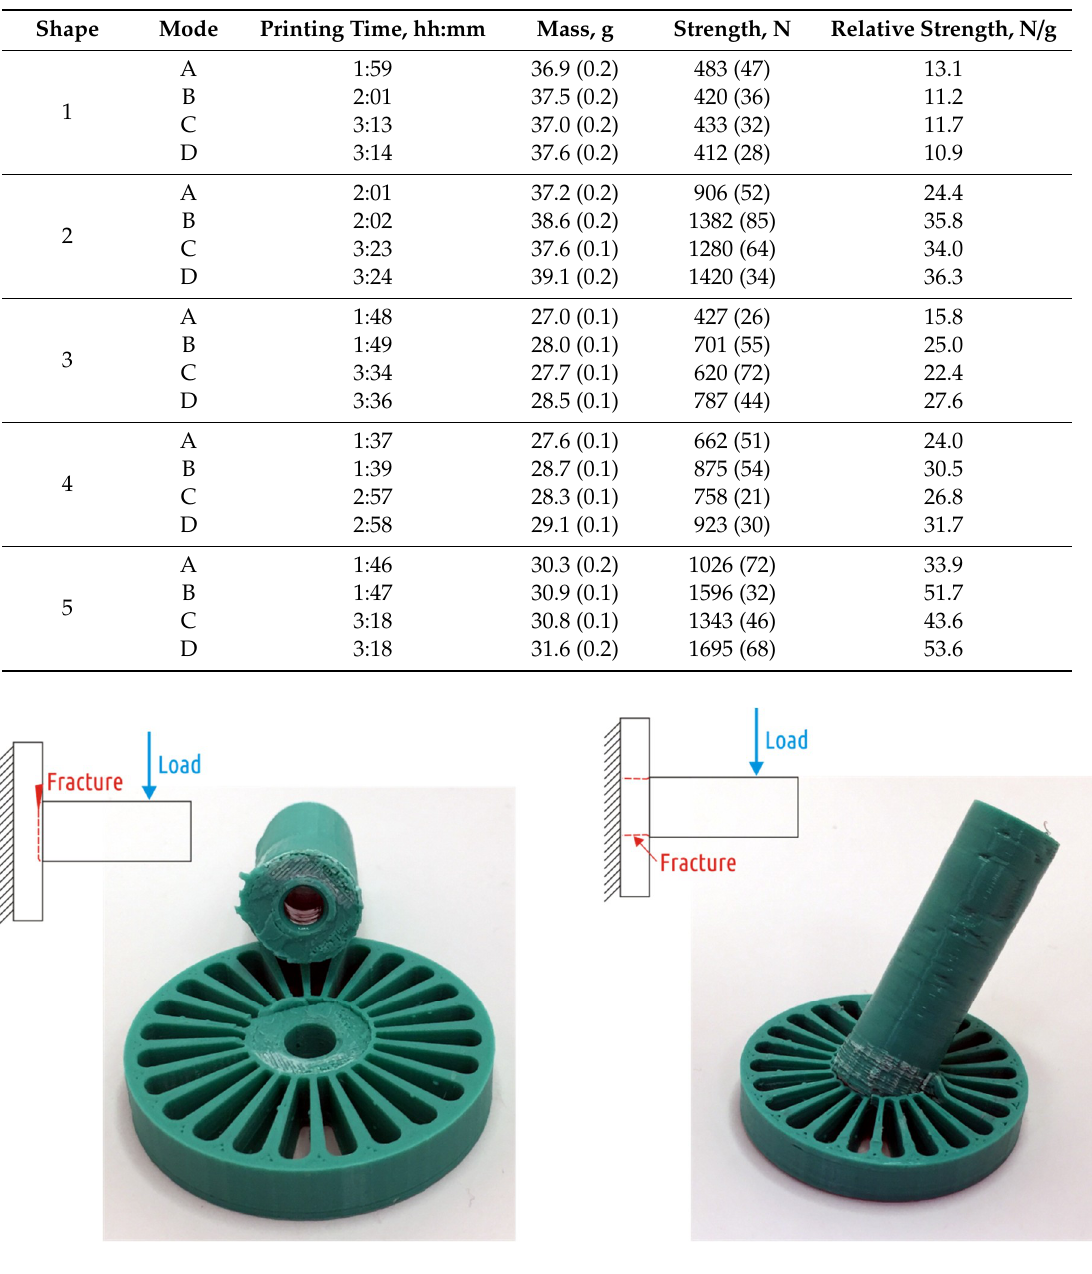
Table 2. Experimental data. The first value is the average and the value in parentheses denotes standard deviation.